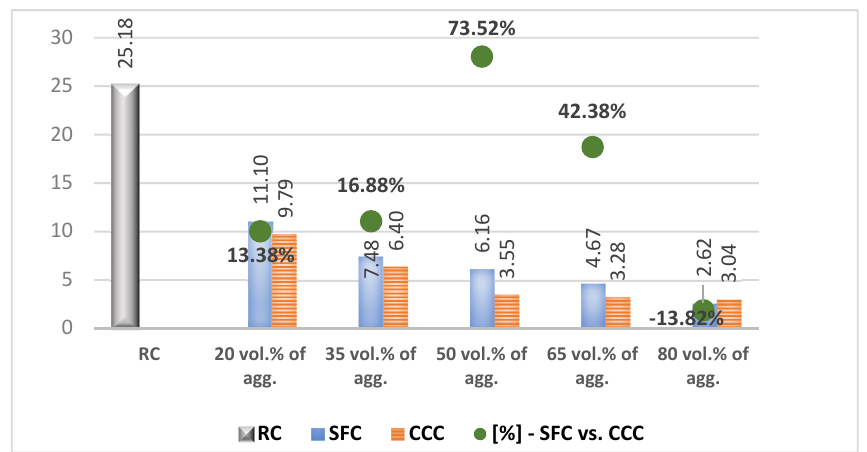
Figure 8. Compressive strength of concrete with 20, 35, 50, 65 and 80% vegetal aggregates, determined 28 days after pouring [N/mm 2 ].